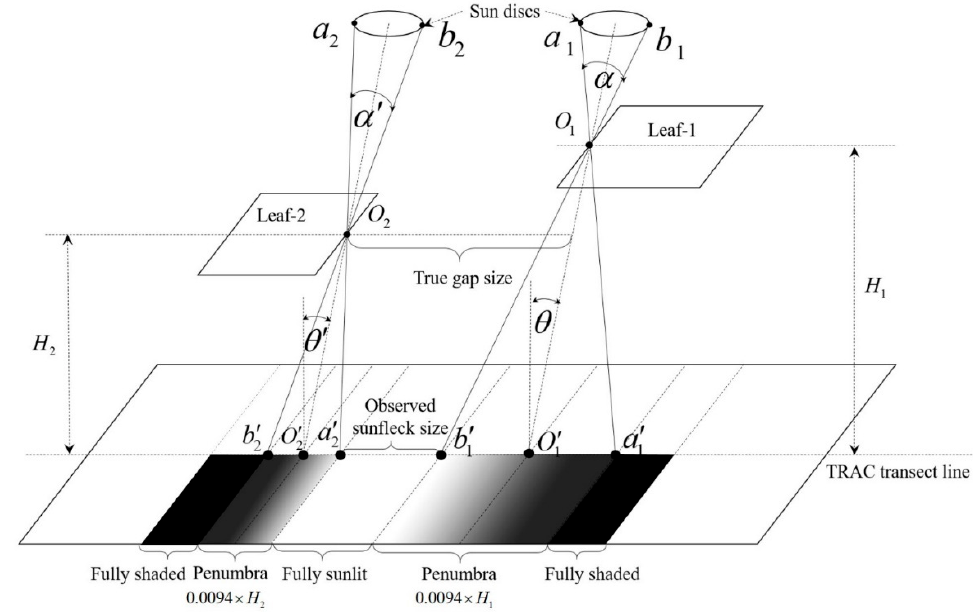
Figure 2. Schematic diagram showing the penumbra effects of leaves at different heights on the PAR estimation and sunlit leaf identification.